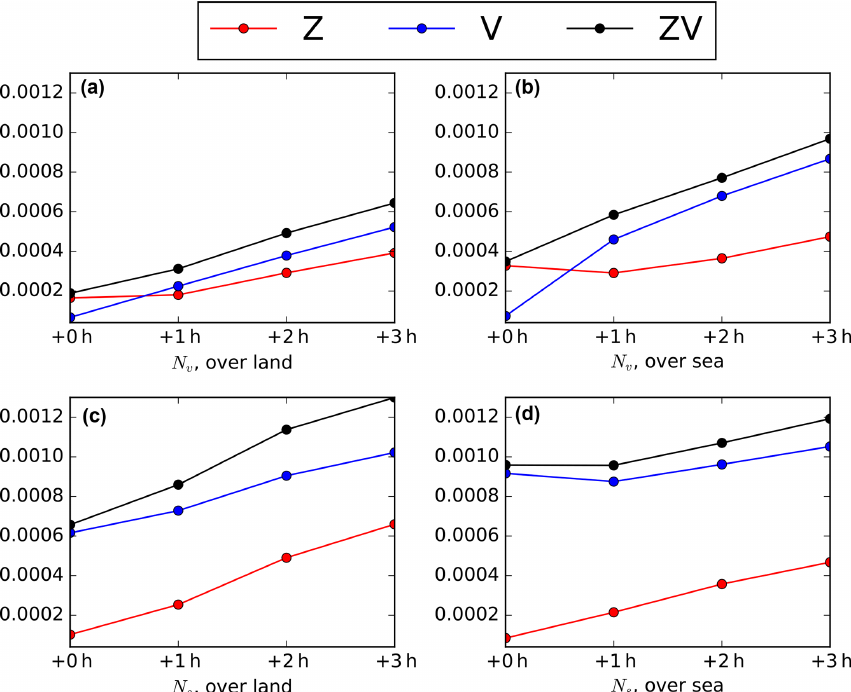
Figure 10. Kinetic ( N s ; c and d ) and humidity ( N v ; a and b ) contribution terms of the exergy distances as a function of the forecast term over land (a, c) and over sea (b, d) for the Z SOP1 (red curve), V SOP1 (blue curve) and ZV SOP1 (black curve)